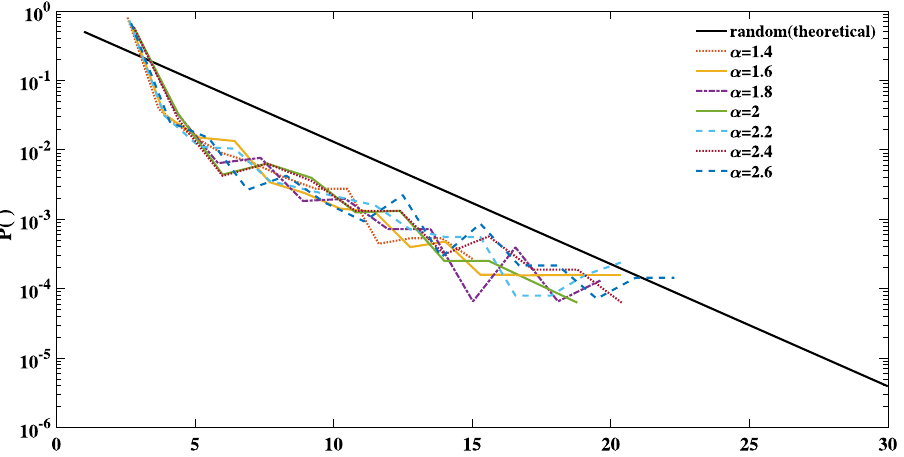
Figure 8. Semi-logarithmic presentation of degree distributions for: any random process (solid black line) which follows Eq. (5), and various runs of simulation of the nano-flare emission model with α ∈ [1.4 3.2], τ d = 10 , and p f = 0.2